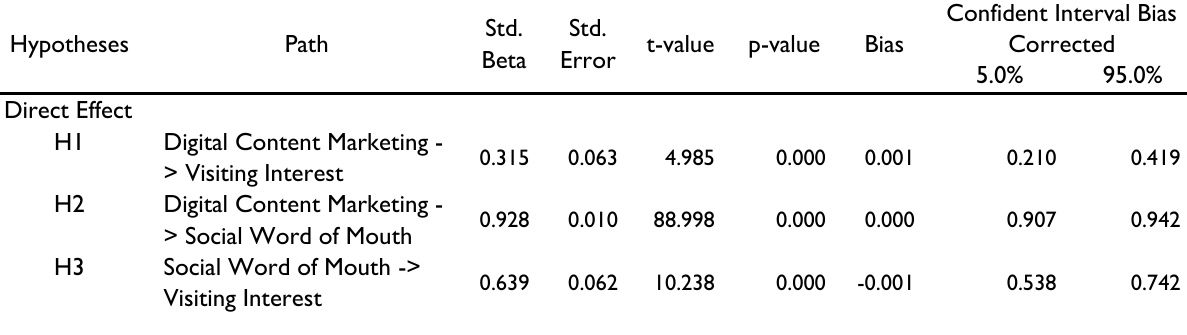
Table 6. Results of the Direct and Indirect Effect Hypothesis Testing